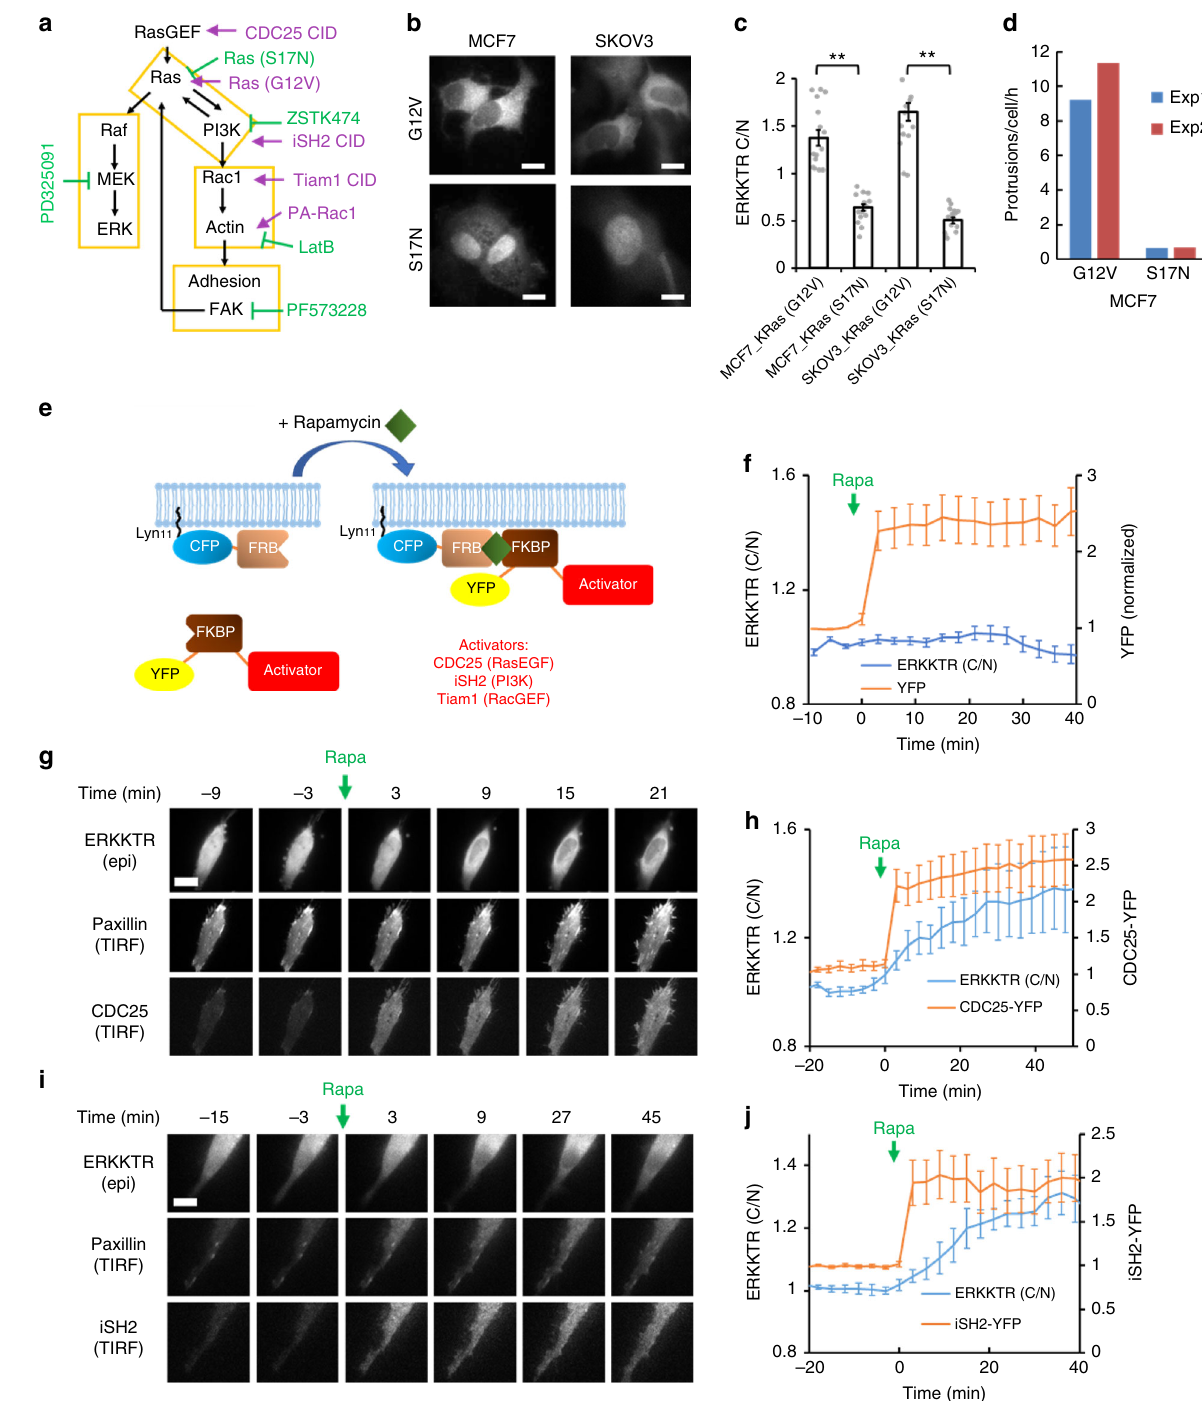
Fig. 3 Perturbation analyses of the signaling network. a Schematic of activating (magenta) and inhibitory (green) perturbations to the signaling network. CID: chemically induced dimerization. b Representative confocal images of ERKKTR-GFP in cells expressing Ras(G12V) and Ras(S17N). c Quanti fi cation of C/N ratio of ERKKTR in cells expressing Ras(G12V) and Ras(S17N) (mean ± s.e.m., n = 16 cells). ** p < 0.001 by two-tail unpaired t -test. d Protrusion frequency of MCF7 cells expressing Ras(G12V) and Ras(S17N). The analysis was done by FDM (see Methods) and results from two independent experiments are shown. e Schematic of CID. Rapamycin induces membrane recruitment of an FKBP-fused signaling activator through dimerization with the membrane-tethered FRB-Lyn, allowing for rapid activation of signaling events. f Recruitment of YFP-FKBP control (mean ± s.e.m., n = 14; intensity in TIRF normalized to pre-stimulus levels). g Representative time-lapse images of ERKKTR-RFP (epi fl uorescence), GFP-paxillin (TIRF), and YFP-FKBP-CDC25 (TIRF) showing that acute activation of Ras by CID induced adhesive protrusions and ERK activation. h Kinetics of YFP-FKBP-CDC25 recruitment and ERKKTR (C/N) response to rapamycin treatment (mean ± s.e.m., n = 8 cells). i , j Representative images for PI3K activation by CID of iSH2 ( i ) as well as the corresponding kinetics of YFP-FKBP-iSH2 and ERKKTR responses (mean± s.e.m., n = 7 cells) ( j ). Scale bars: 10 µ